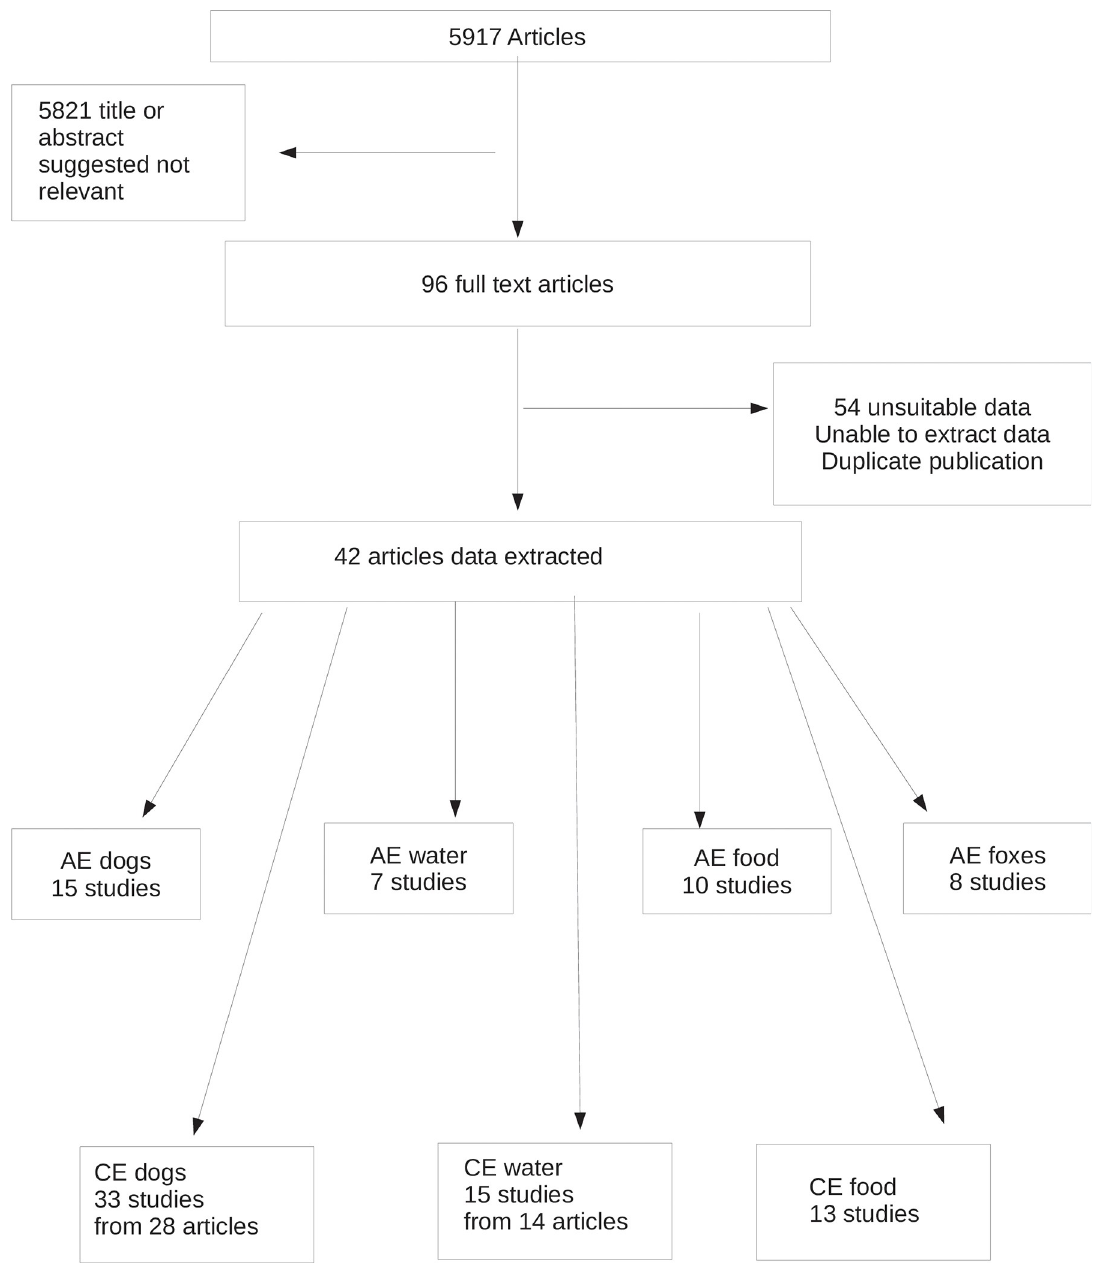
Fig 1. Prisma flow diagram with the search strategy